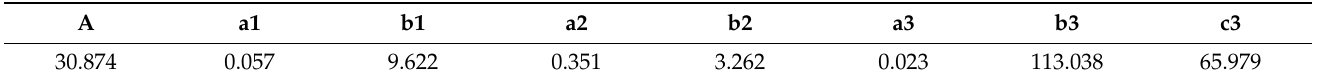
Table 3. Table 3. The coefficients of the optimal quadratic exponential